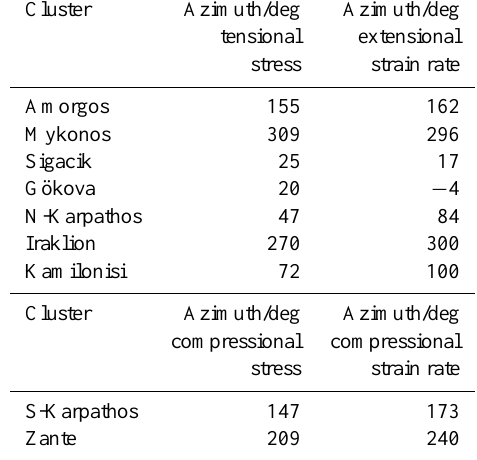
Table 2. Comparison of azimuths of tensional/compressional prin- cipal stress axes with extensional/compressional principal axes of strain rate for shallow earthquake